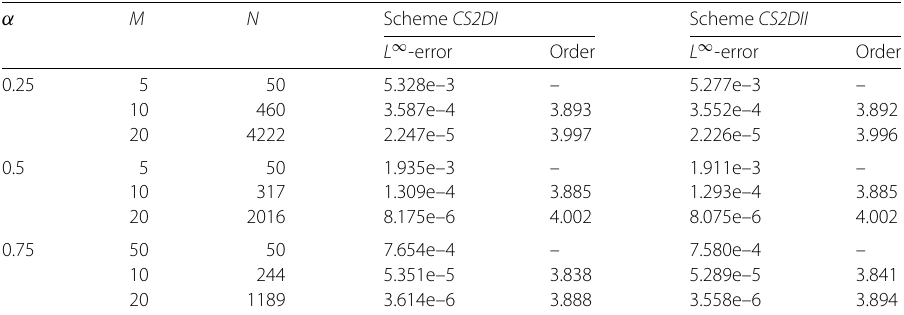
Table 5 Errors and convergence orders of schemes CS2DI and CS2DII for Example 3, at T = 1 with different α , M , and N